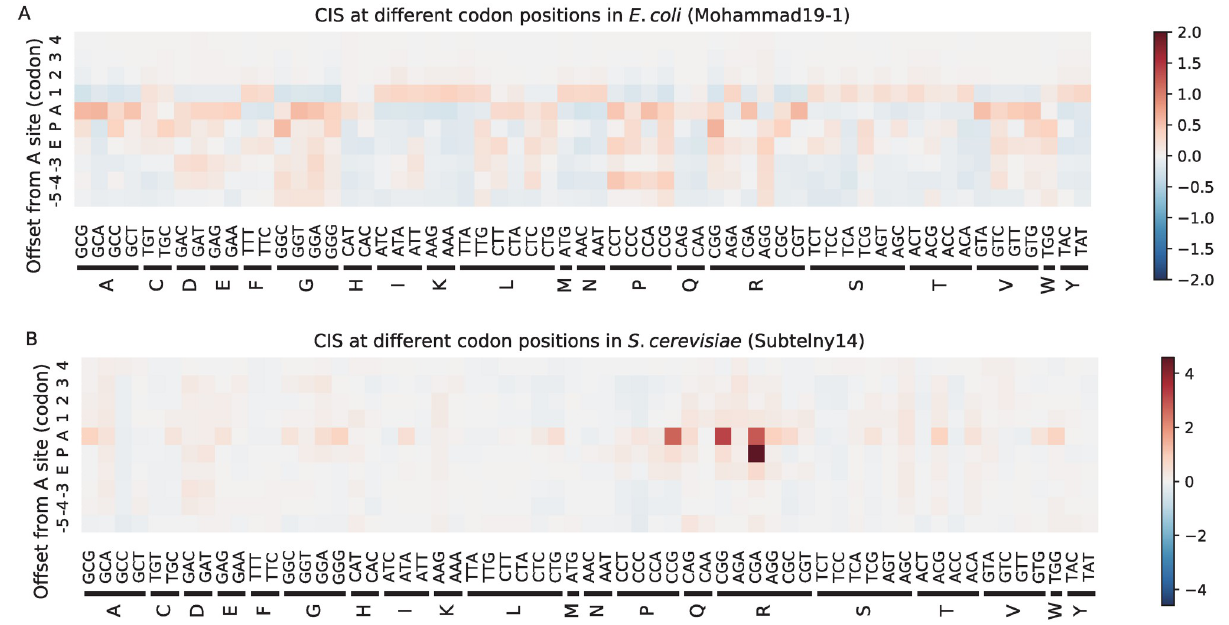
Fig 4. The codon-distance impact score (CIS c , d ) values measuring the contributions of codon type c at distance d to the predicted ribosome densities of the current A site for the Mohammad19-1 (A) and Subtelny14 (B) datasets, respectively. The horizontal axes represent the codon types and vertical axes represent the positions relative to the ribosomal A sites. Only positions within the ribosome protected region (i.e., ranging from − 5 to + 4 codons relative to the A sites) are shown. The positive values (red) of CIS refer to inhibition in translation efficiency, while the negative values c , d (blue) refer to